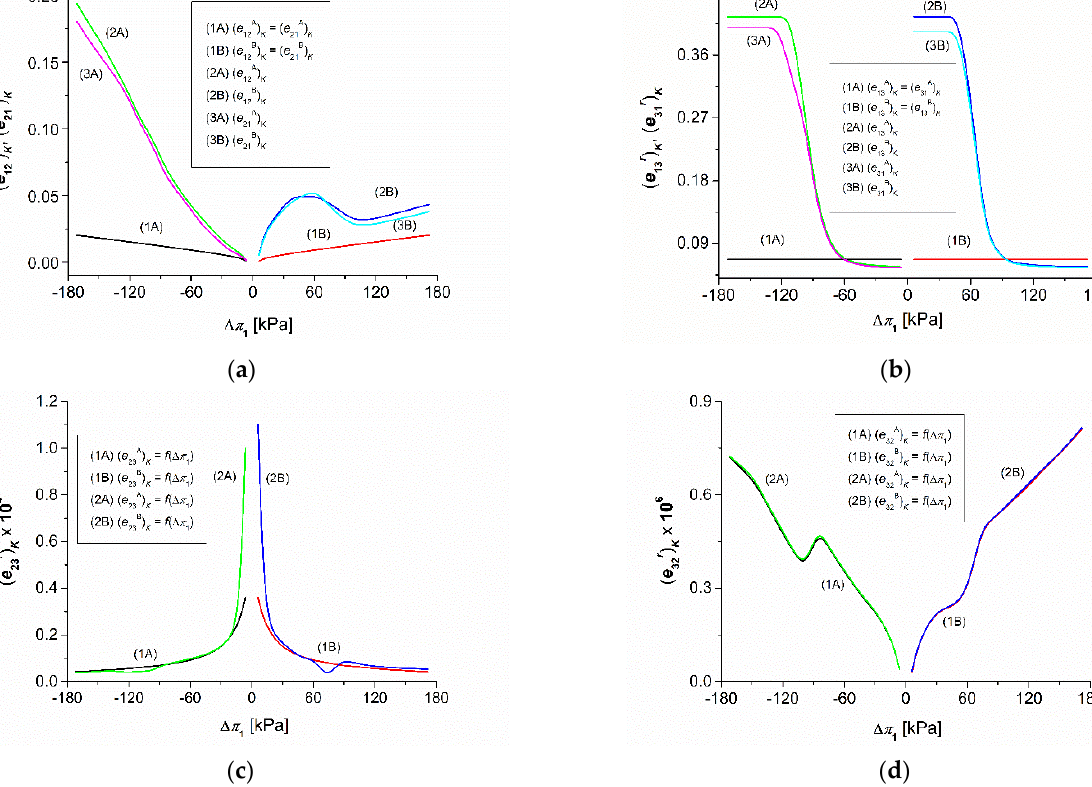
Figure 7. The ( c ) ( i , j ∈ {1, 2, 3}, r = A, B) coefficients as functions of glucose osmotic pressure difference ( ∆𝜋 1 ) with ∆𝜋 2 = 490.2 kPa: (𝑒 12𝑟 ) 𝐾 𝑟 and (𝑒 21𝑟 ) 𝐾 𝑟 ( a ), (𝑒 13𝑟 ) 𝐾 𝑟 and (𝑒 31𝑟 ) 𝐾 𝑟 ( b ), (𝑒 23𝑟 ) 𝐾 𝑟 ( c ), (𝑒 32𝑟 ) 𝐾 𝑟 ( d ).